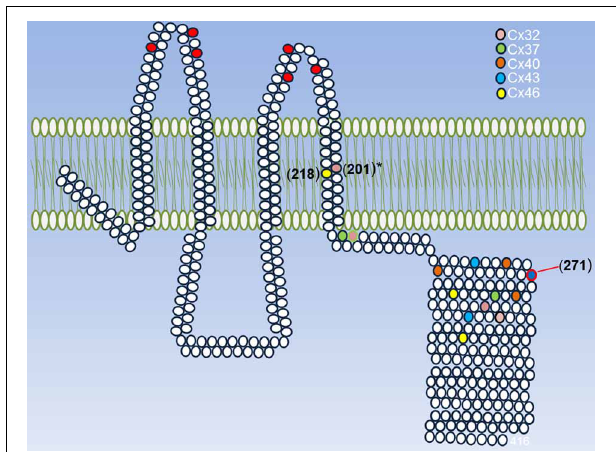
FIGURE 2 | Summary of Cys that can be modified by ROS/RNS. A representative Cx is shown and its conserved extracellular Cys is highlighted (red circles) and each cysteine present in Cxs 32, 37, 40, 43, and 46 are shown in different colors. These Cxs were chosen because they are sensitive to redox potential. The exact position for each Cys was taken according to their last aa in the TM4. The asterisk in Cys201 of Cx32 indicates that their mutations induce the appearance of a disease and the Cys 271 of Cx43 is the only one that has proved to be